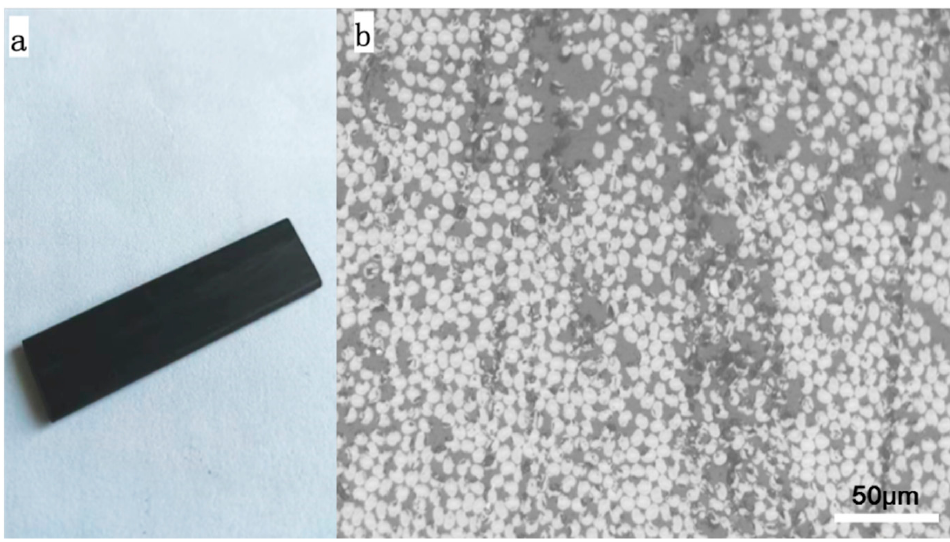
Figure 1. ( a ) The digital image of CFRE plate, and ( b ) the optical image of its